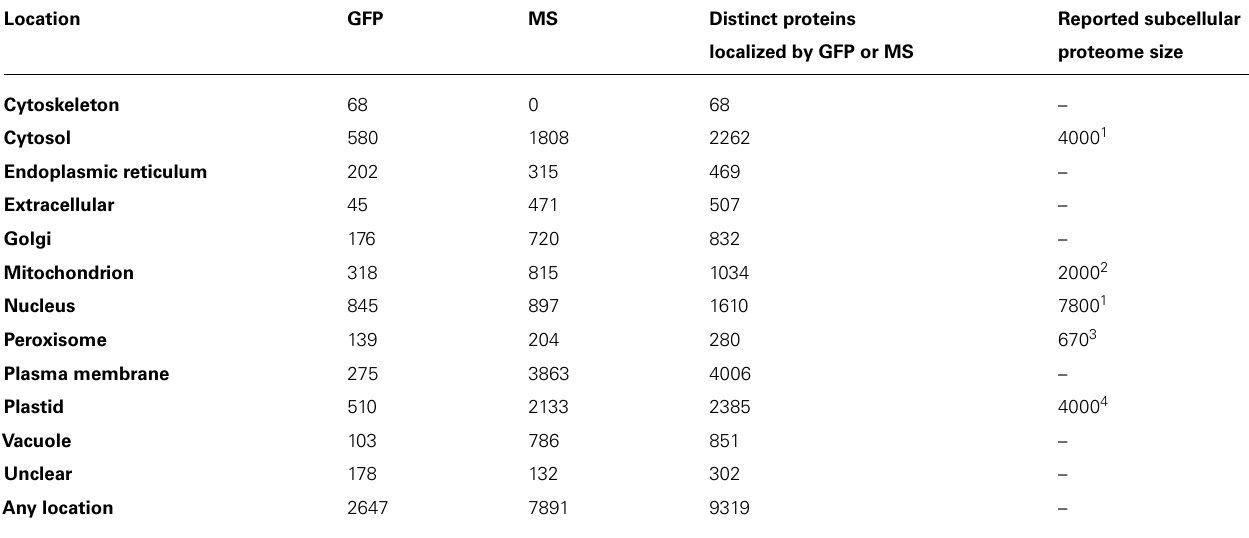
Numbers represent distinct Arabidopsis proteins that are located in 11 subcellular compartments and a 12th category referred to unclear, for which location data are consideredspeculativebytheauthorsofthereport.AlsolistedareestimatedproteomesizesforfivesubcellularcompartmentsofArabidopsis: cytosol, mitochondrion, nucleus, peroxisome, and plastid. GFP, data from fluorescent protein tagging experiments; MS, data from mass spectrometry analysis of isolated subcellular